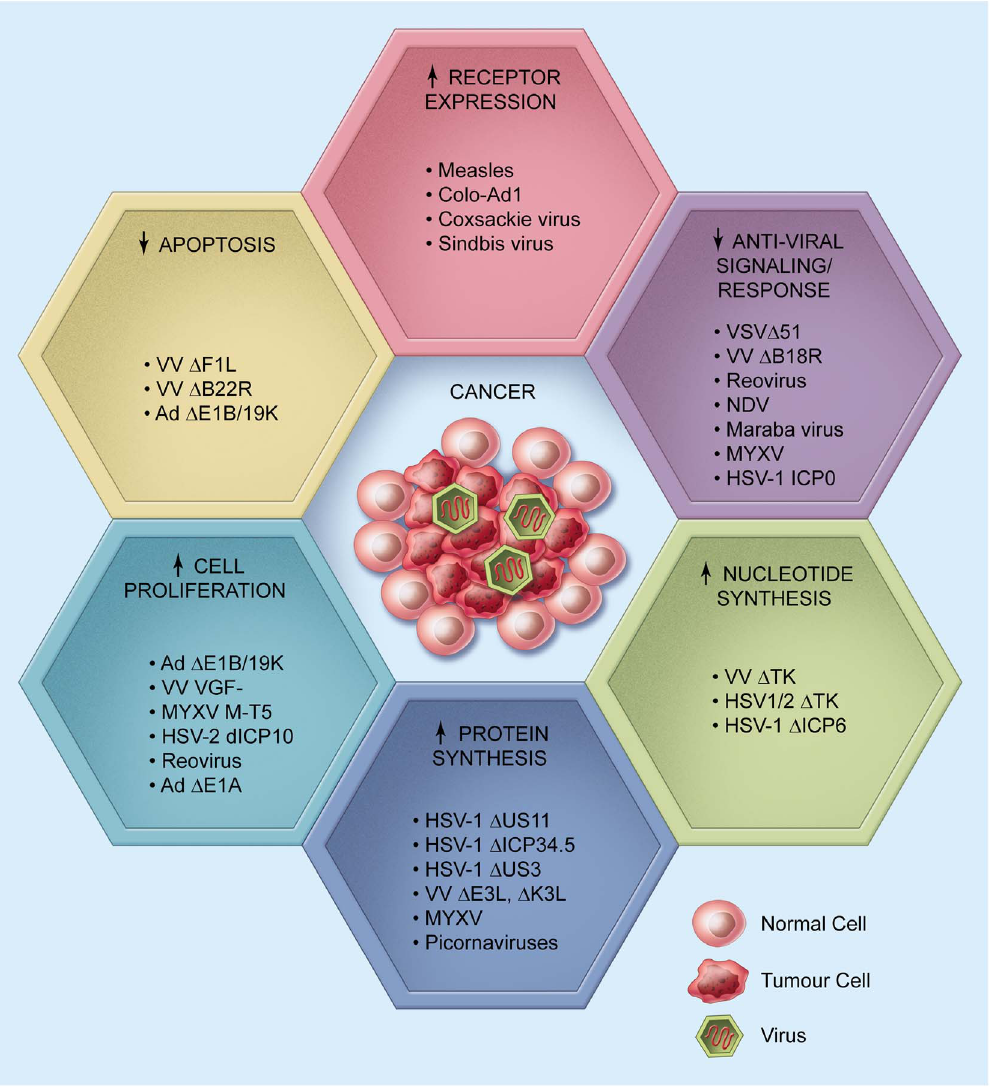
Figure 2. Oncolytic Viruses Are Designed to Grow in the Tumour Niche. There are at least six key critical features of tumour cell growth that can be targeted by oncolytic viruses. These include changes in the expression of viral-host cell receptors, the antiviral response, nucleotide and protein synthesis, cell proliferation, and apoptosis. A number of engineered or selected oncolytic viruses exist that can exploit one or more of these malignant